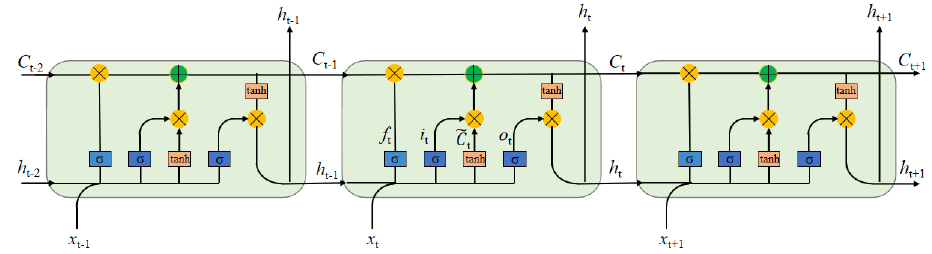
Figure 14. LSTM structure.